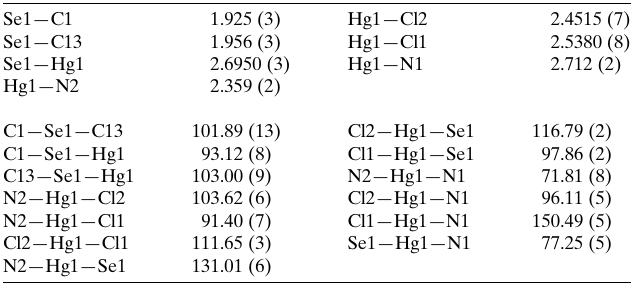
Table 1 Selected geometric parameters (A˚ , (cid:4) ).